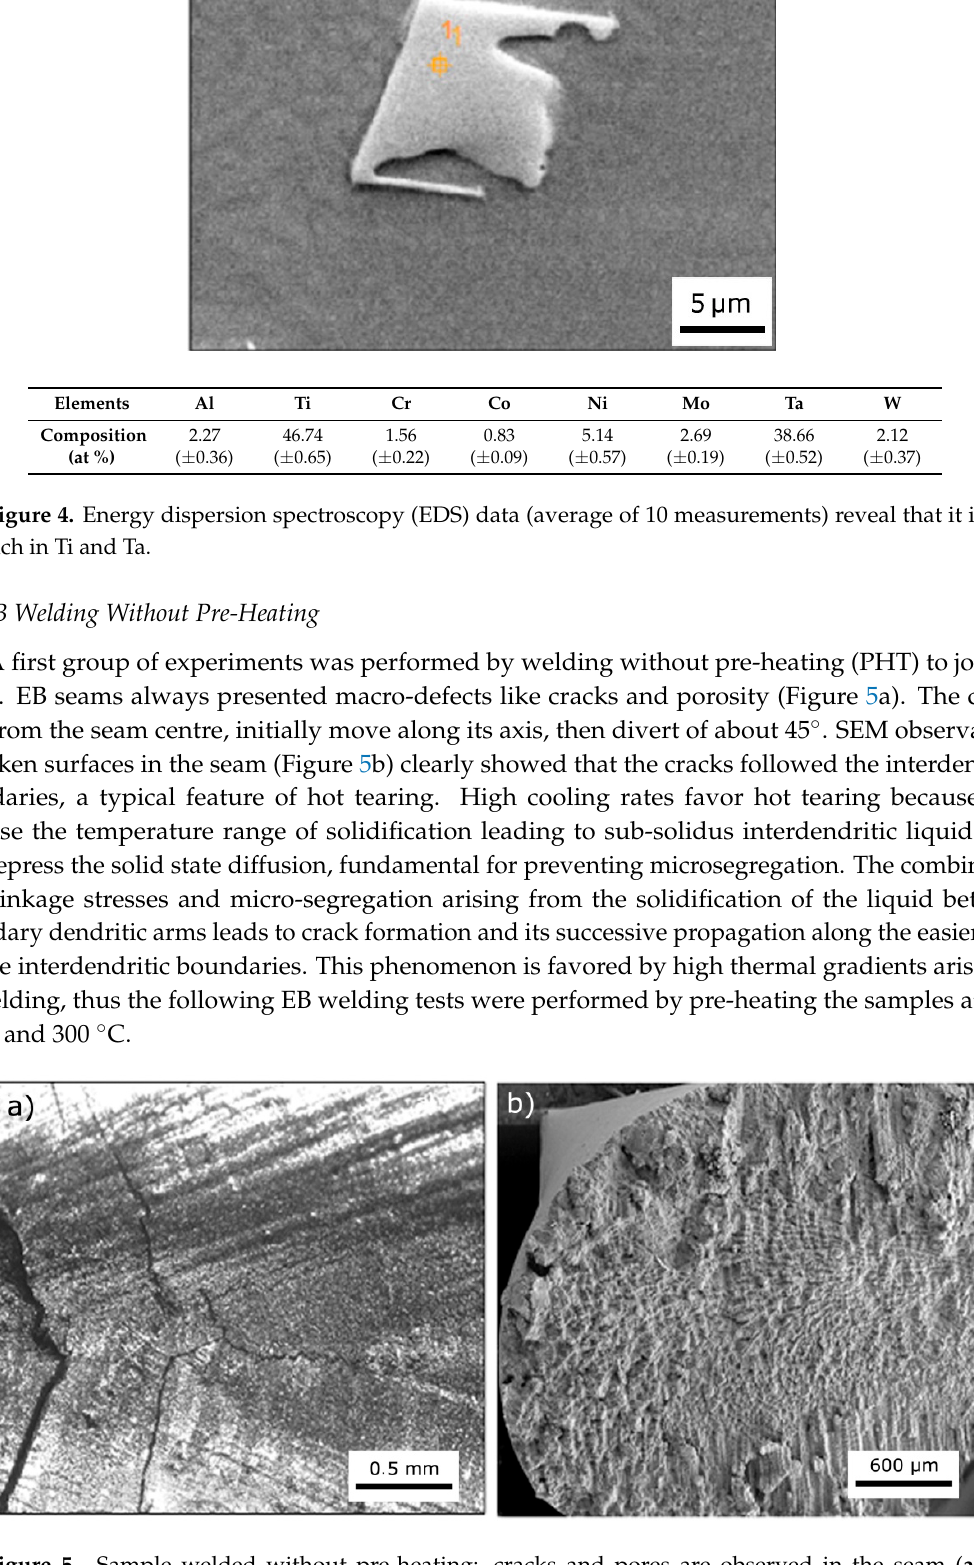
Figure 5. Sample welded without pre-heating: cracks and pores are observed in the seam ( a ); fracture surface clearly shows the dendritic structure ( b ).